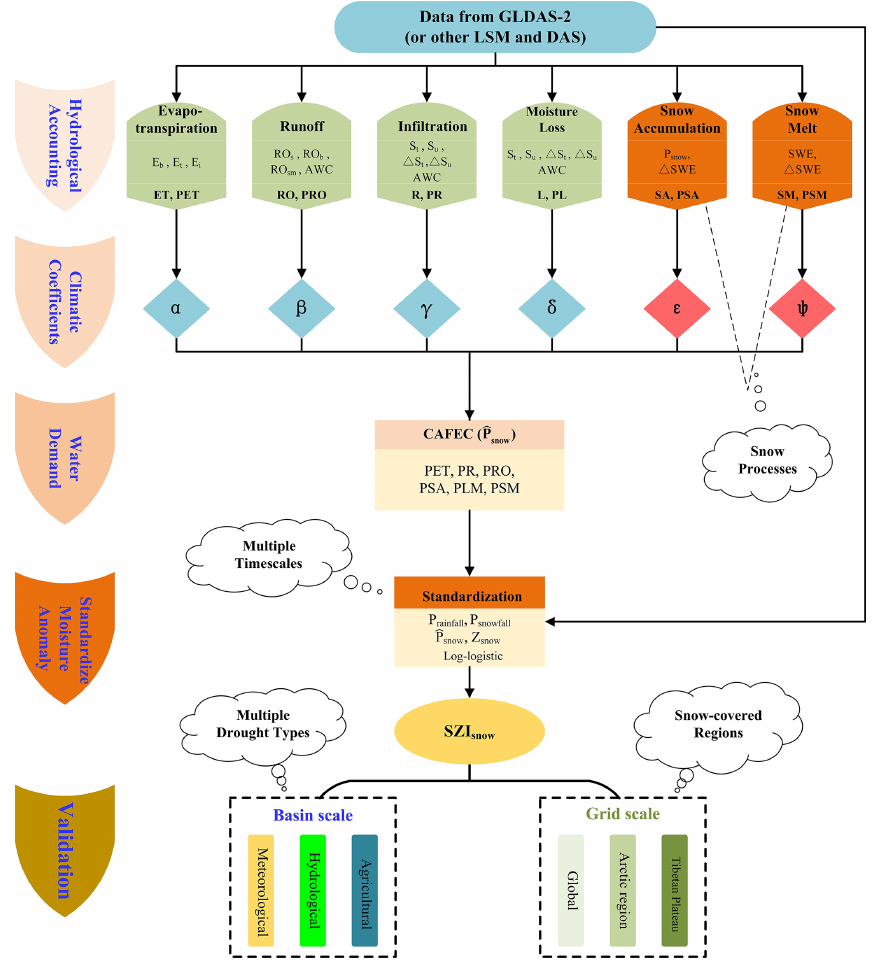
Figure 3. The procedure flowchart describing the production and validation of SZI snow . Variables derive the SZI snow from GLDAS-2 (or other LSM and DAS). The production of SZI snow includes four steps. The SZI snow is validated at basin scale for three types of drought and at grid scale across different regions worldwide. The cloud-shape annotation shows the advantages of the SZI snow